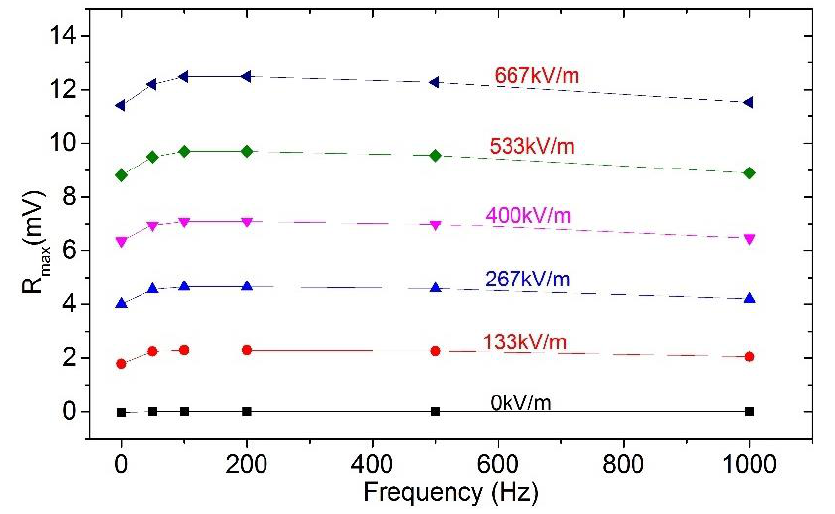
Figure 15. The frequency characteristics of the EFM.